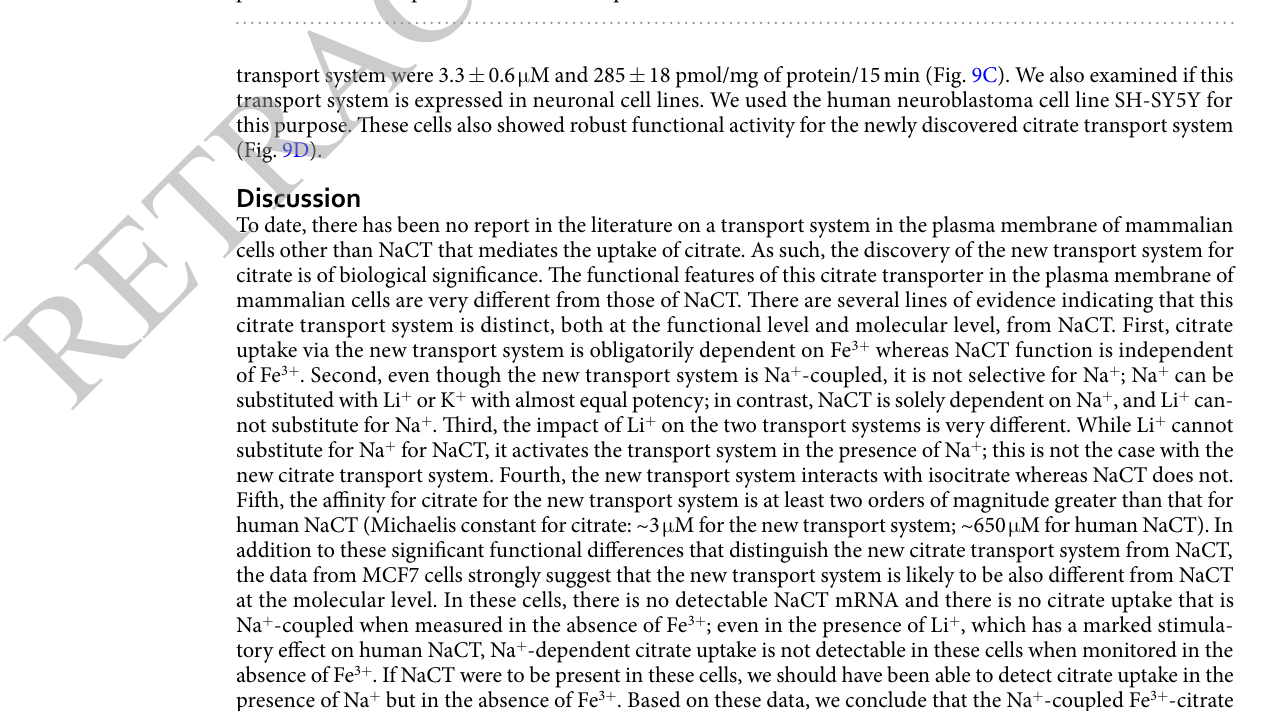
Figure 9. Expression of the Na + -coupled Fe 3 + -citrate uptake system in mouse primary hepatocytes and in a human neuronal cell line. ( A ) Hepatocytes were cultured to confluence and then used for measurement of [ 14 C]- citrate (3.5 μ M) uptake in the presence (NaCl buffer, pH 7.5) with and without FeCl 3 (50 μ M) or in the absence of Na + (NMDG chloride, pH 7.5). Data are presented as percent of control uptake measured in the presence of Na + but in the absence of Fe 3 + . ** p < 0.01. ( B ) Dose-response for Fe 3 + to stimulate [ 14 C]-citrate (3.5 μ M) uptake in the presence (NaCl buffer, pH 7.5) in hepatocytes. ** p < 0.01. ( C ) Substrate saturation kinetics for the Na + -coupled Fe 3 + -citrate uptake in hepatocytes. ( D ) The human neuronal cell line SH-SY5Y was cultured to confluence and then used for measurement of [ 14 C]-citrate (3.5 μ M) uptake in the presence (NaCl buffer, pH 7.5) with and without FeCl 3 (50 μ M) or in the absence of Na + (NMDG chloride, pH 7.5). Data are presented as percent of control uptake measured in the presence of Na + but in the absence of Fe 3 +